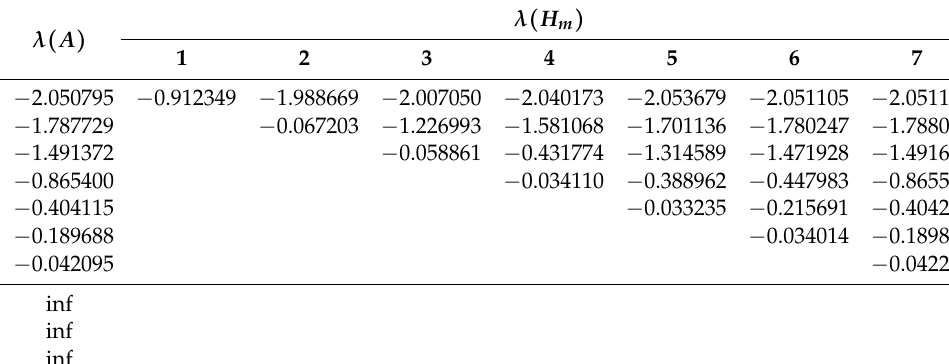
Table 2. Eigenvalues of the original and the regularized systems.